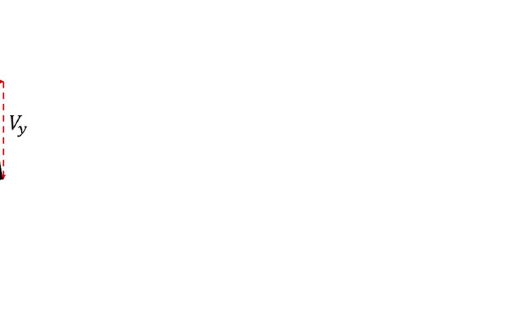
Figure 5. Prediction of travel distance using initial